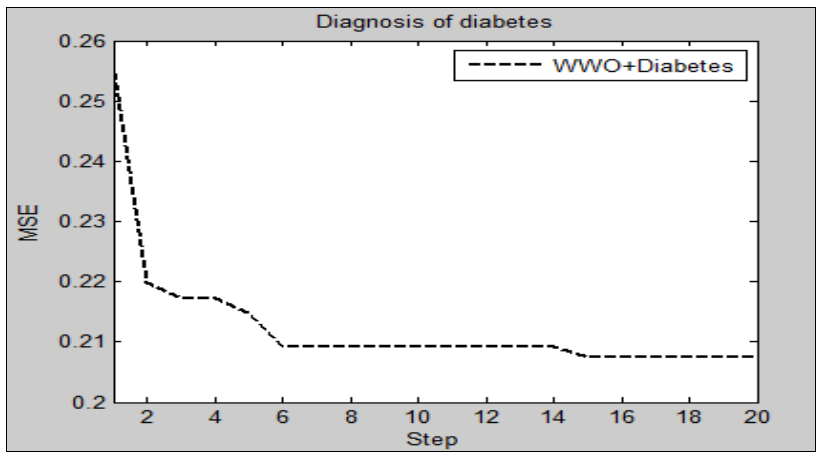
Figure 8. Reducing the mean error rate of identifying diabetic patients with a population of 10 subjects for 20 iterations in the proposed method.